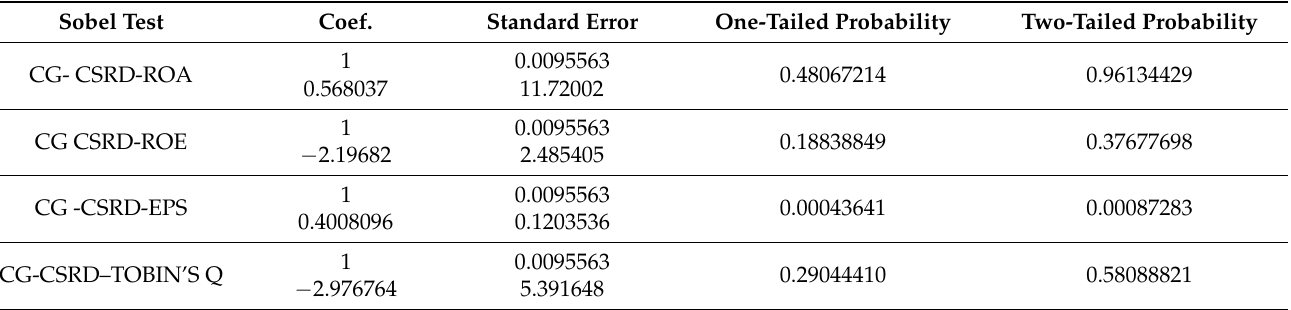
Table 5. Result of mediating role of corporate social responsibility disclosure between corporate governance and bank performance by Sobel